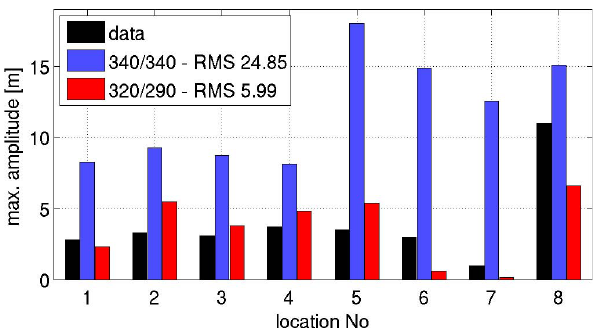
Fig. 11. Flow depth comparison in locations marked in Fig. 9 for strike angles of plates A/C set to 340/340 and 290/320.